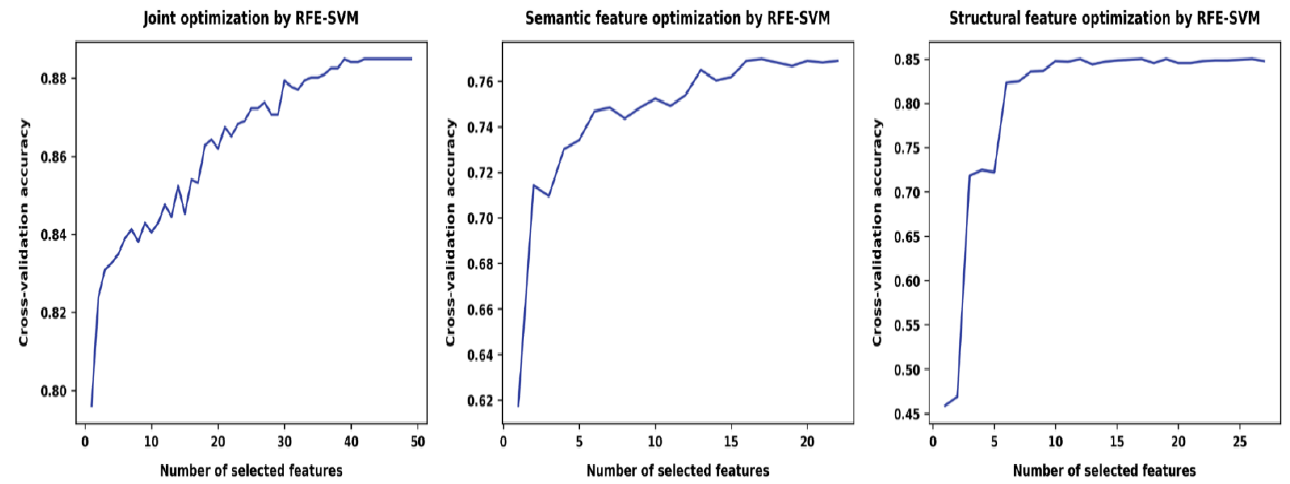
Figure 1. Automatic feature elimination RFE on different feature sets The cross-validation classification accuracy of automatic feature optimisation on se- mantic features was 0.77. The optimised semantic feature set reduced original semantic features from 22 to 17, representing a 22.7% reduction rate: medicine/health (B), emotion (E), government (G), dwelling (H), employment (I), sports (K), living things (L), locations (M), measurements (N), general substances (O), time (T), environment (W), psychology